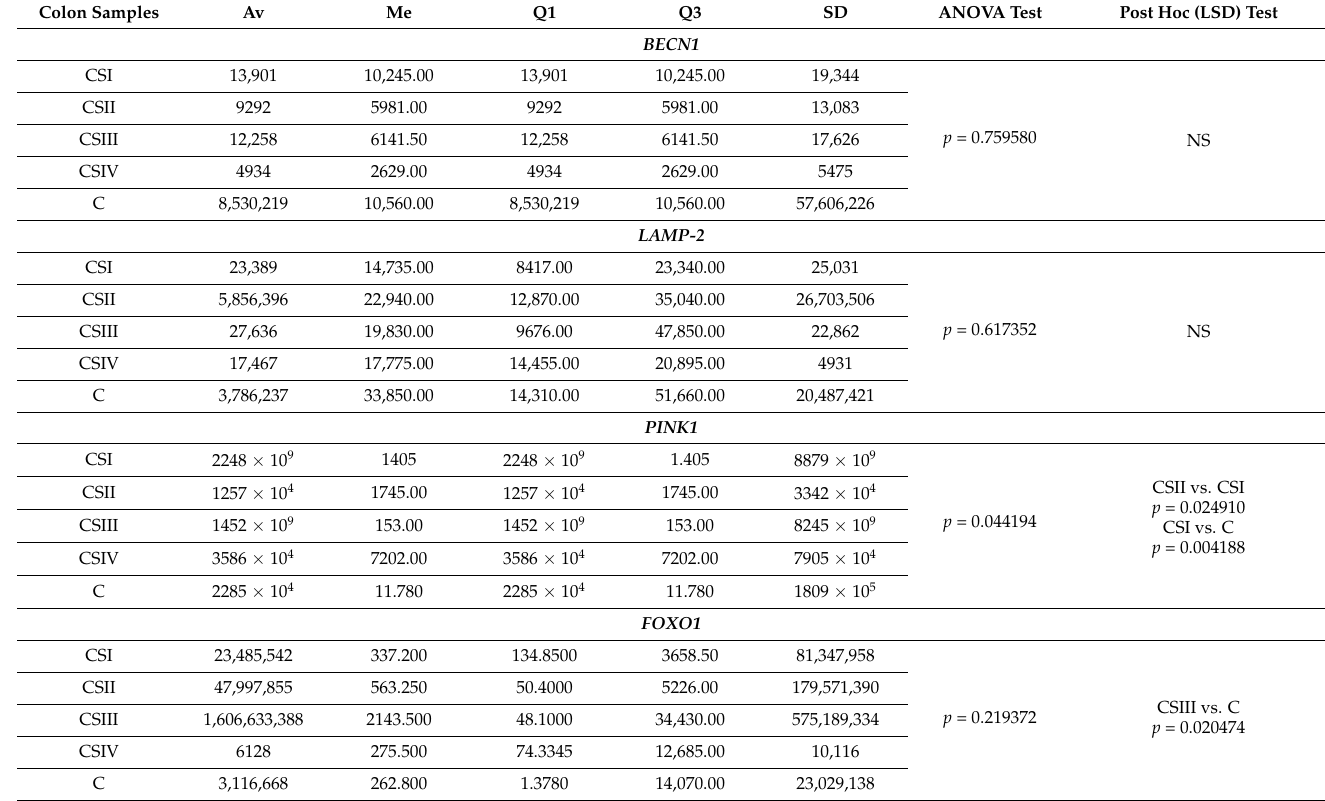
Table 3. Values of descriptive statistics, ANOVA test and post hoc test of mRNA coding for the studied genes in colorectal cancer specimens and in the control specimens.